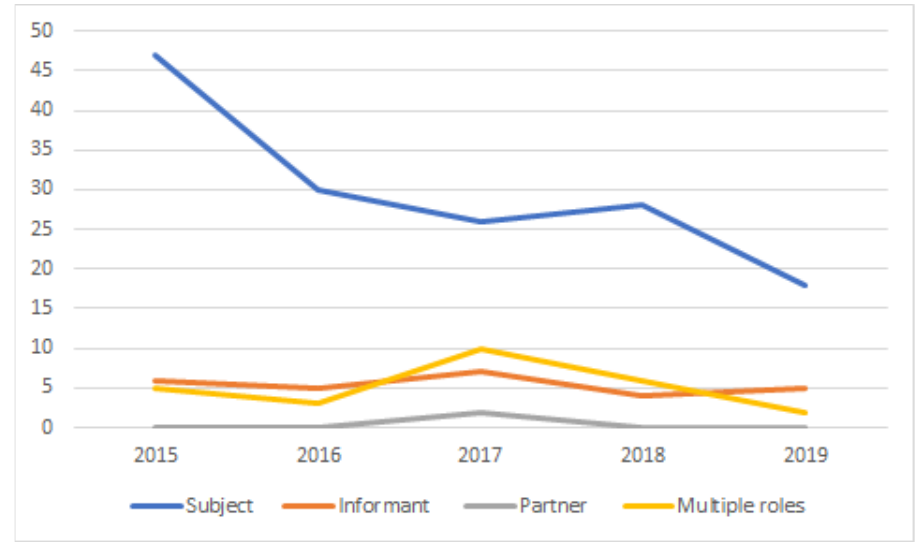
Figure 2. Older people’s participation in learning studies 2015–2019 (authors’ own